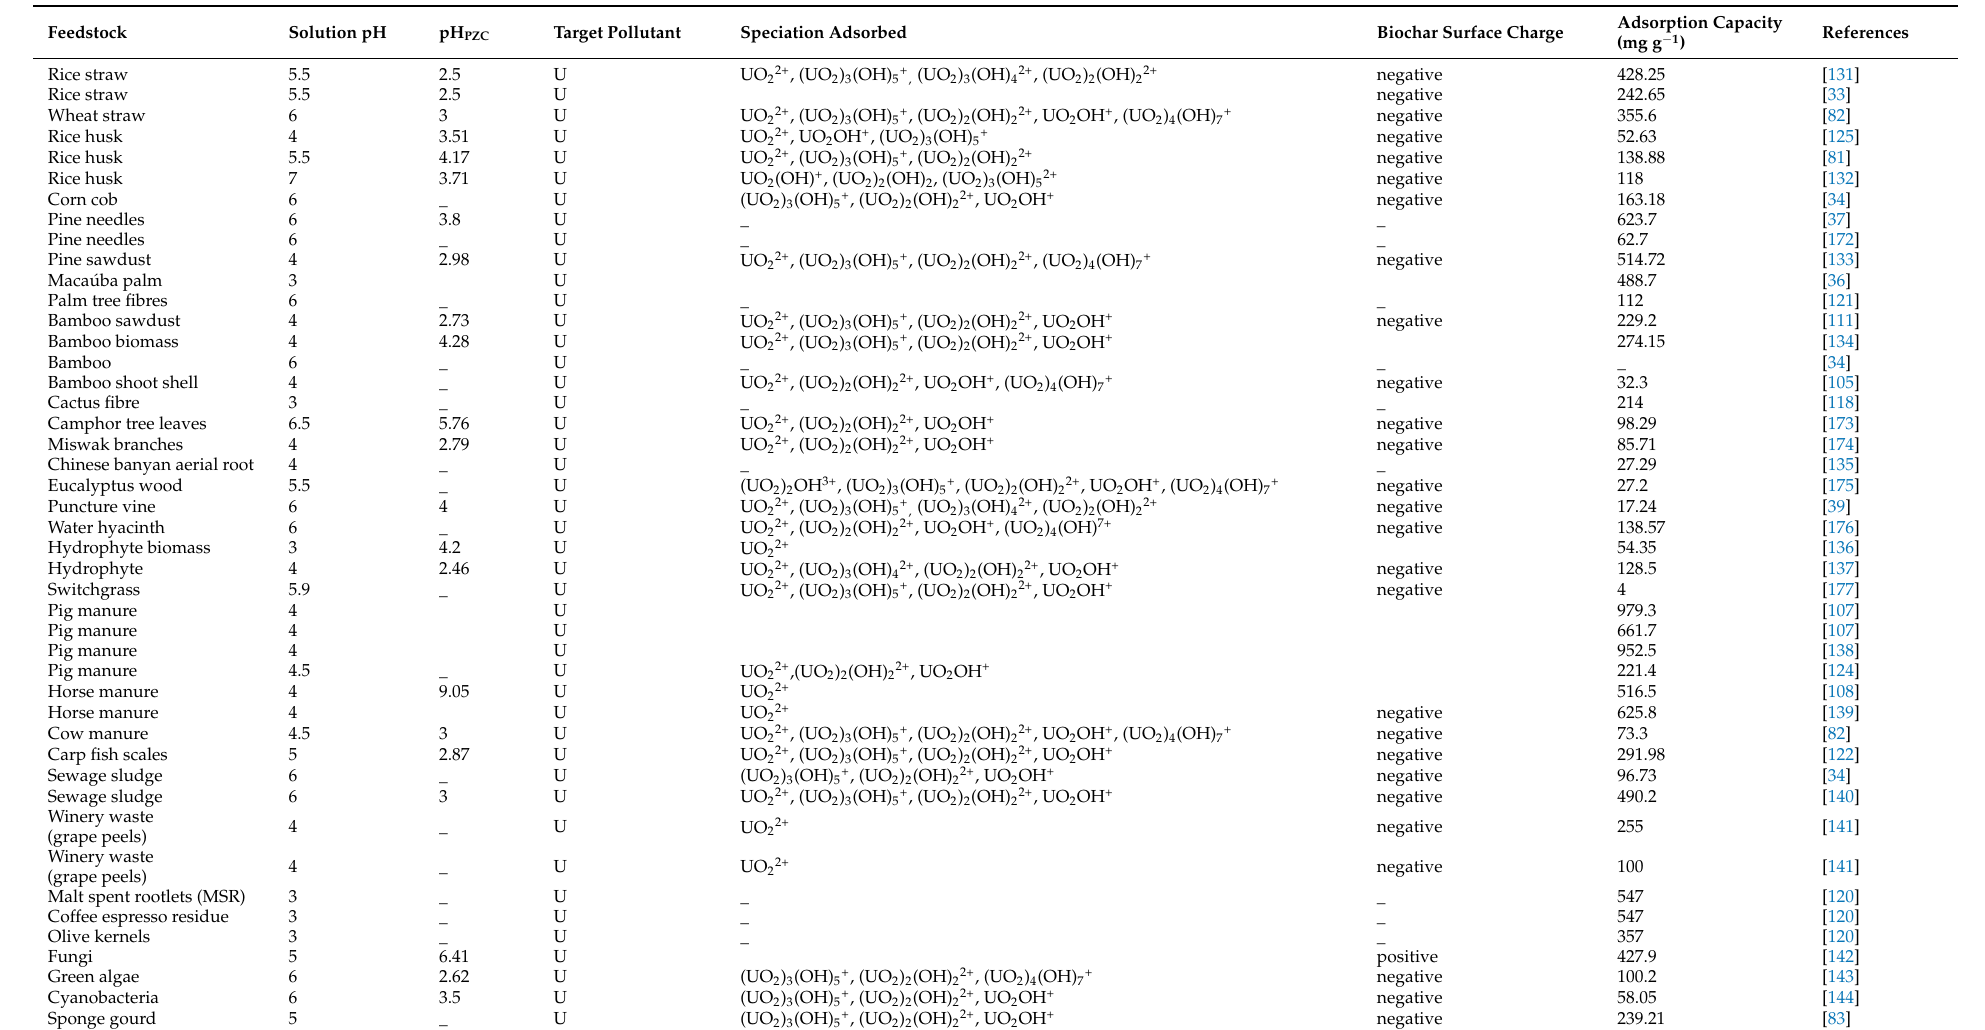
Table 2. Influence of solution pH on the adsorption of